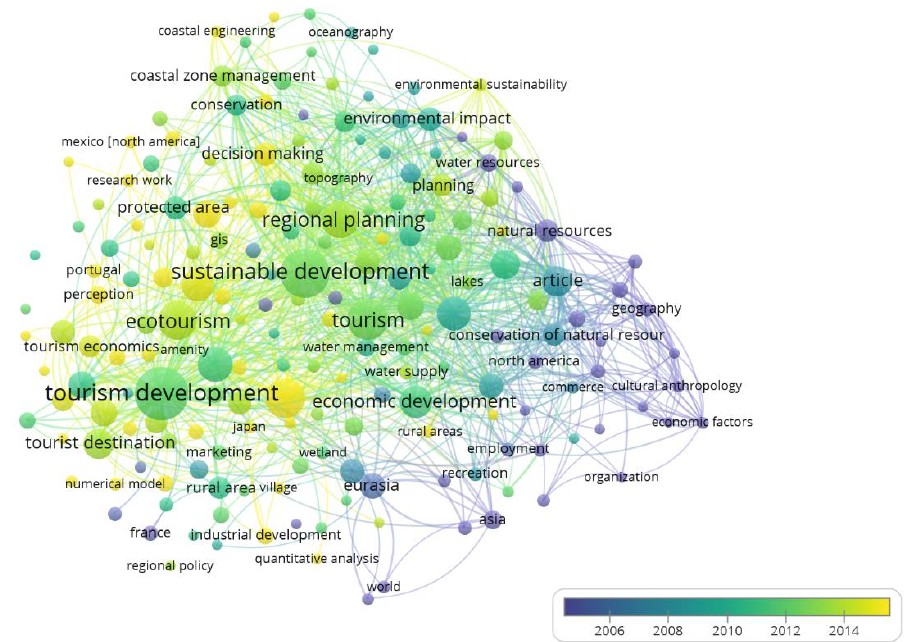
Figure 12. Key words. Source: Authors’ own data .